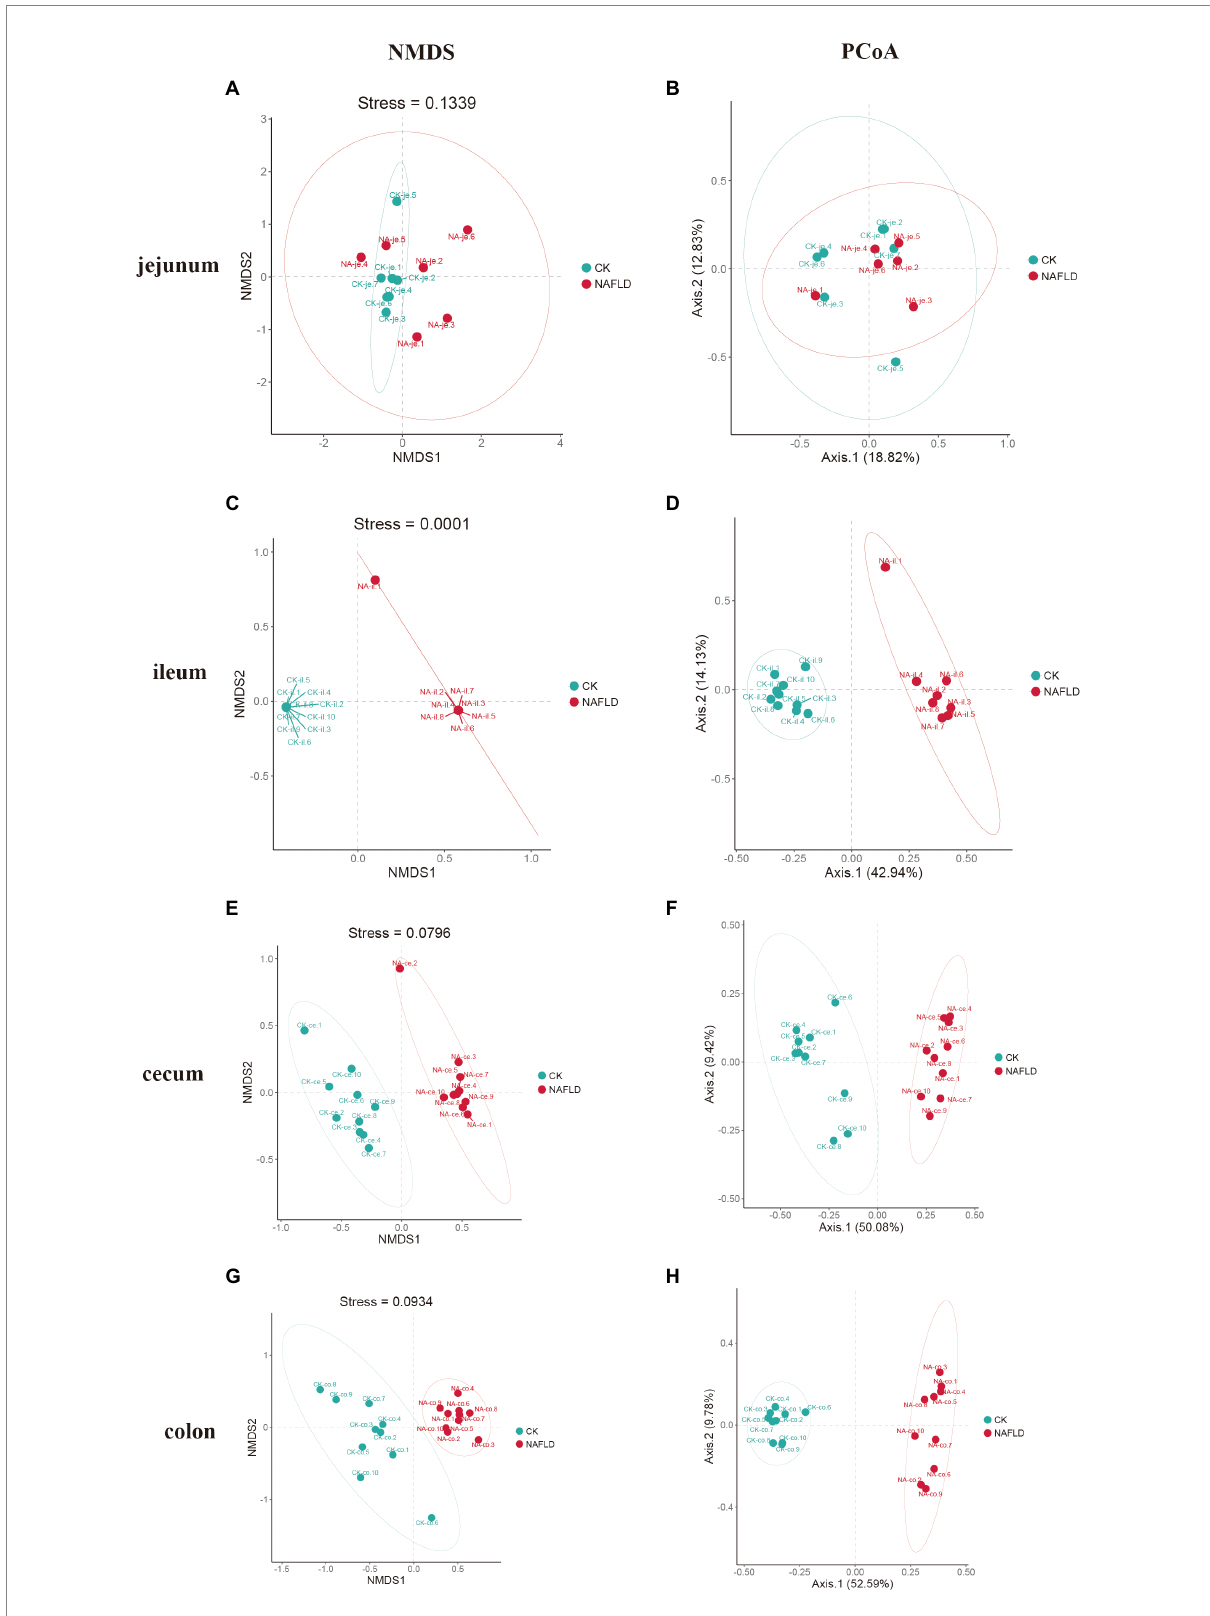
FIGURE 4 Beta diversity analysis of the same intestinal segments between CK group and NAFLD group assessed by NMDS and PCoA based on Bray-Curtis distance. (A,B) Jejunum, (C,D) ileum, (E,F) cecum, and (G,H)